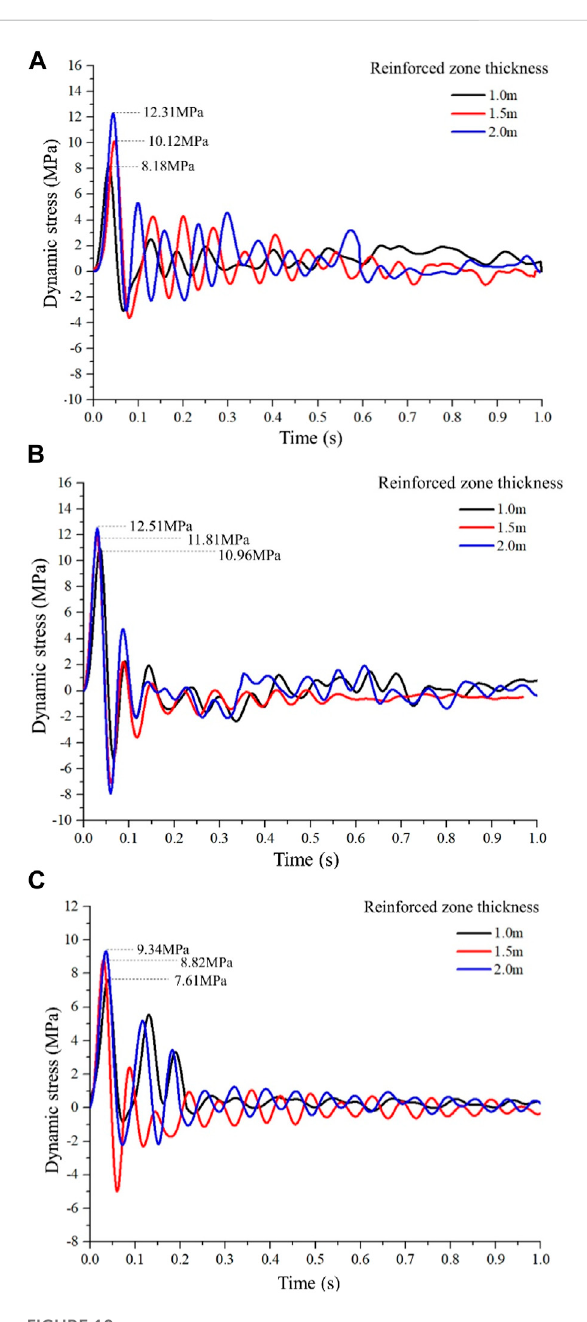
FIGURE 10 Dynamic stresses with different reinforced zone thicknesses for monitoring points located at the inner wall of (A) roadway top, (B) roadway side, and (C) roadway